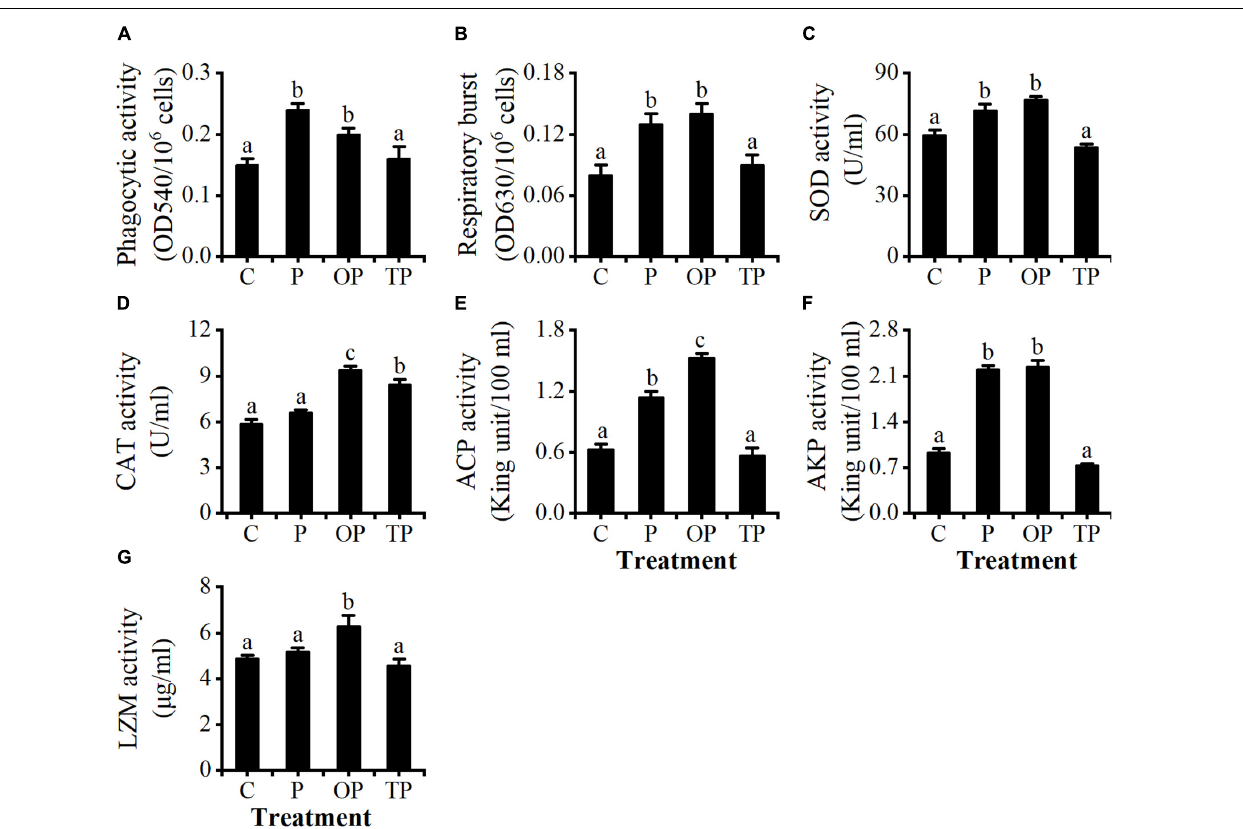
no differences were observed between the control and TP treatment ( P > 0.05), nor between the P and OP treatments ( P > 0.05) ( Figures 1A,B